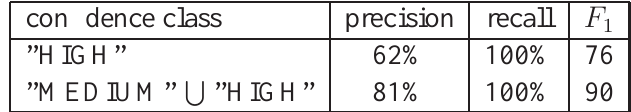
Table 4: Evaluation of LAILAPS relevance ranking